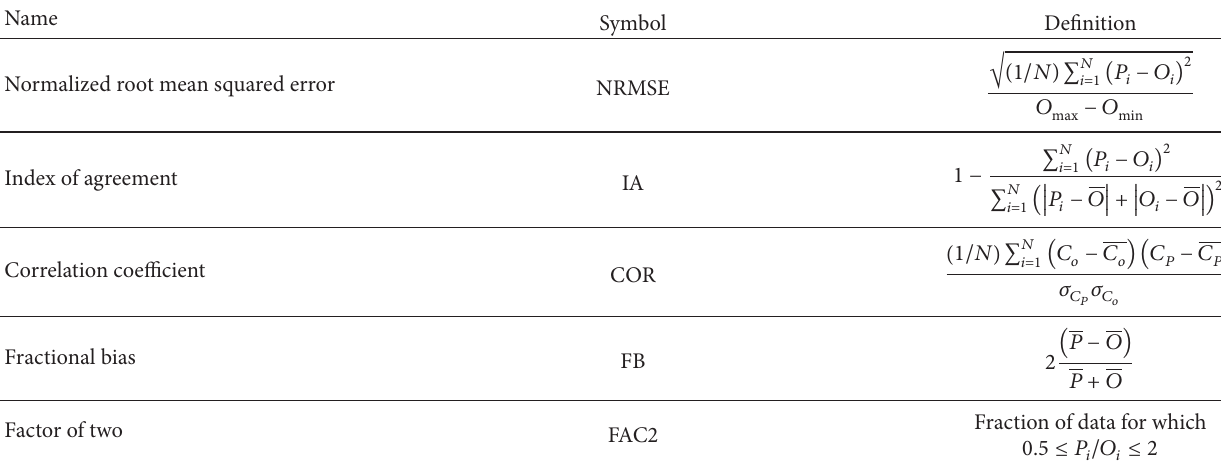
Table 2: Model evaluation statistics and their